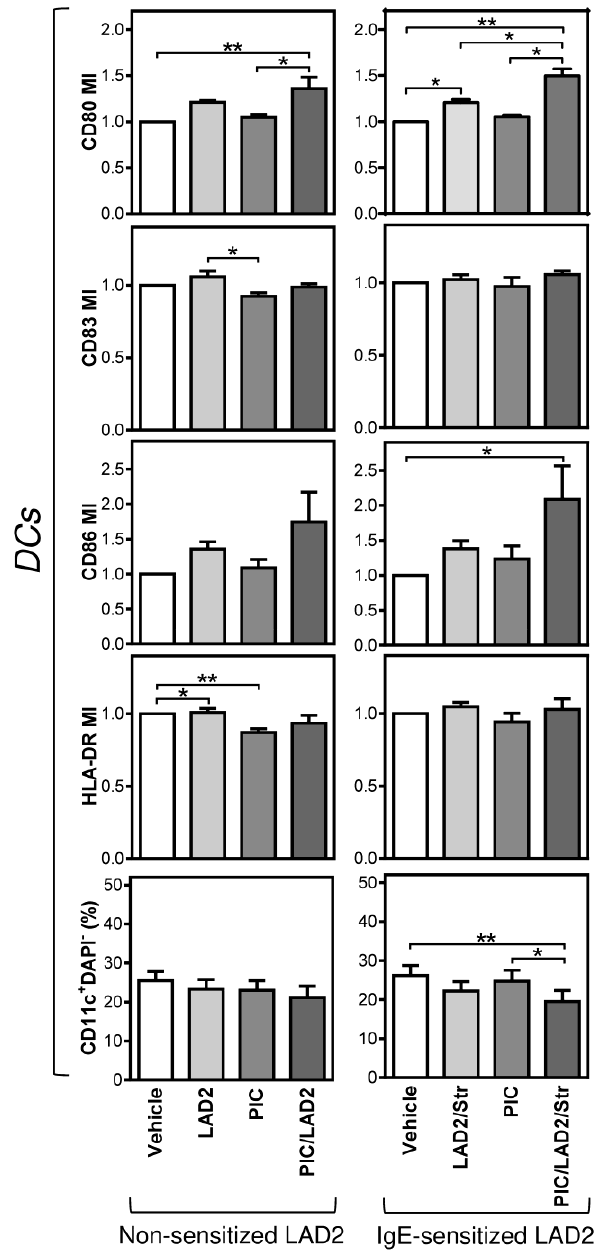
Figure 4. Evaluations of the impact of FcεRI-stimulated LAD2 MCs and poly I:C on the maturation of monocyte-derived DCs produced in the serum-free medium. LAD2 MCs were (right panels), or were not (left panels), sensitized with biotinylated IgE. Then, the cells were placed directly in the following co-culture with monocyte-derived immature(i)DCs with (LAD2/Str), or without (LAD2), streptavidin (Str, 10 µg/mL). Monocyte-derived iDCs were produced in the serum-free medium and matured for 20–24 h in F-bottom 96-well plate wells (0.2 × 10 6 of iDCs in 200 µL of culture medium) in the presence or absence of poly I:C (PIC, 25 µg/mL) by no co-culture (Vehicle) or co-culture with LAD2 MCs at a ratio 1:6 (LAD2 MCs:iDCs). The matured DCs were stained with the fluorescently labeled antibodies specific to the selected maturation markers and analyzed by flow cytometry as in Figure 2. The maturation indexes (MIs) for individual markers and the proportions of viable DCs (DAPI-CD11c+) were evaluated. Bars represent the mean of values and SEM determined in each group. The significance of differences among the group of cells is indicated (* p < 0.05, ** p < 0.01, *** p < 0.001, **** p < 0.0001; n = 6 donors, 1-way ANOVA with the Tukey post-test).